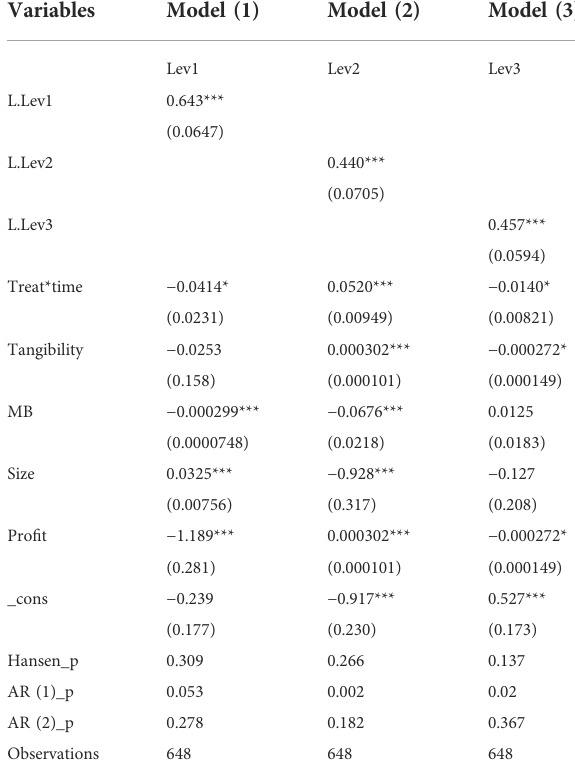
TABLE 4 The DID regression results. TABLE 5 The sys-GMM regression